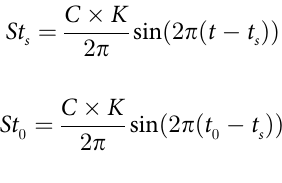
where is the predicted length at age t, L 1 is the asymptotic length, the mean length that fish in a L t given population would reach if they were to grow continuously, K is the curvature parameter is the “ age ” of the fish at zero length if they had always grown as pre- of the VBGF [18] and t 0 dicted by the Equation, and where: